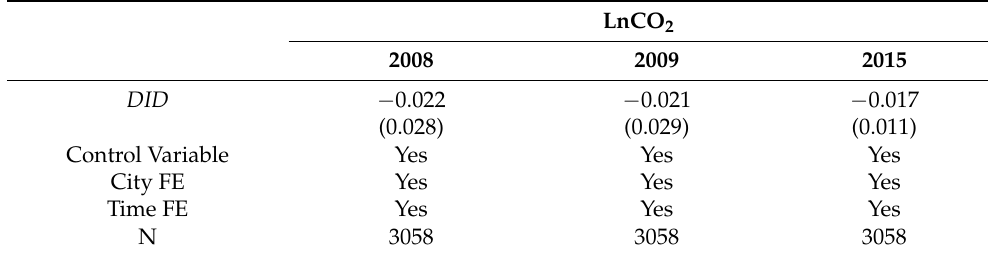
Table 6. Policy time